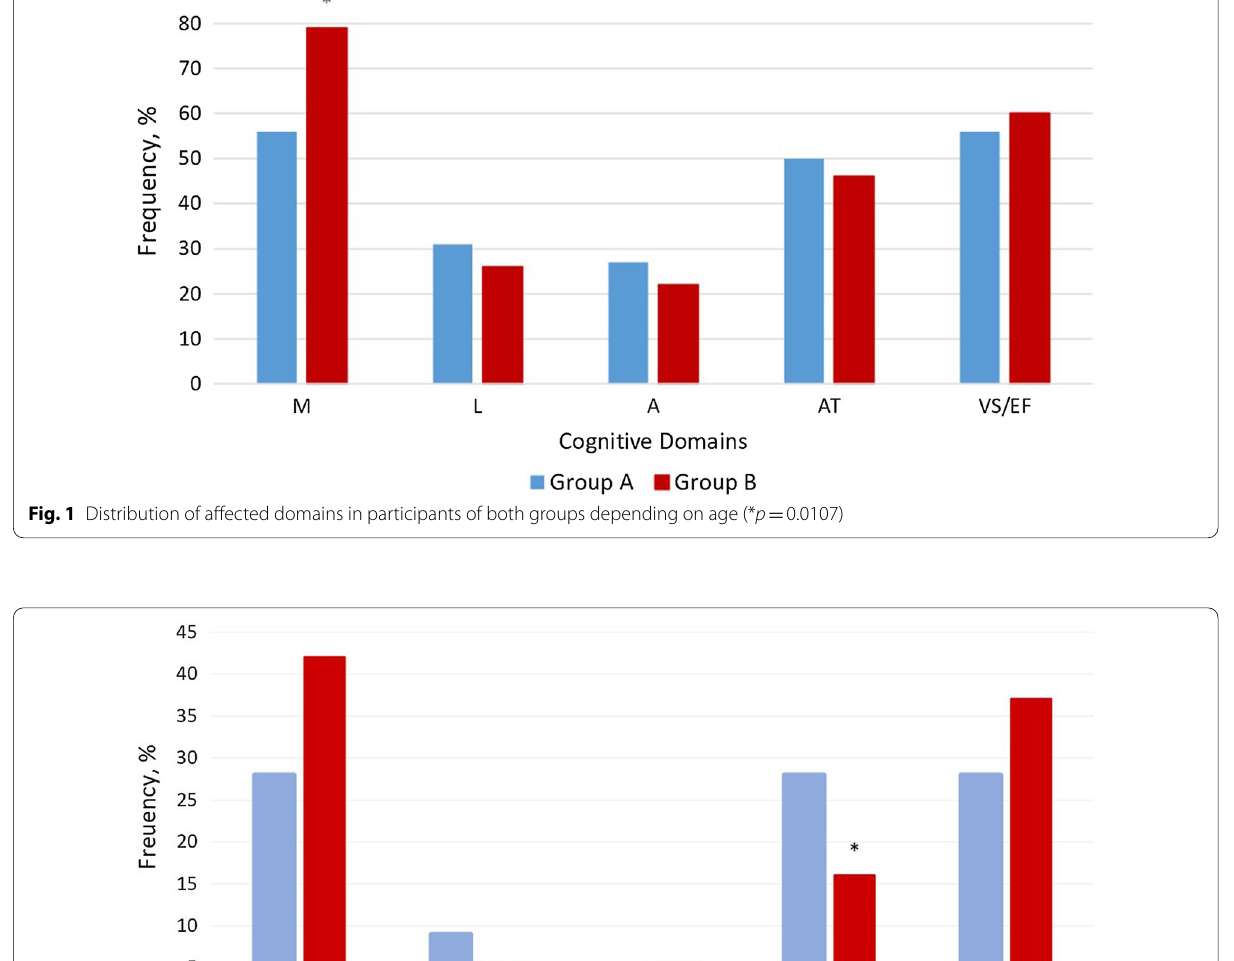
Fig. 2 Distribution of affected domains in both groups depending on age in absence of CI (* p <